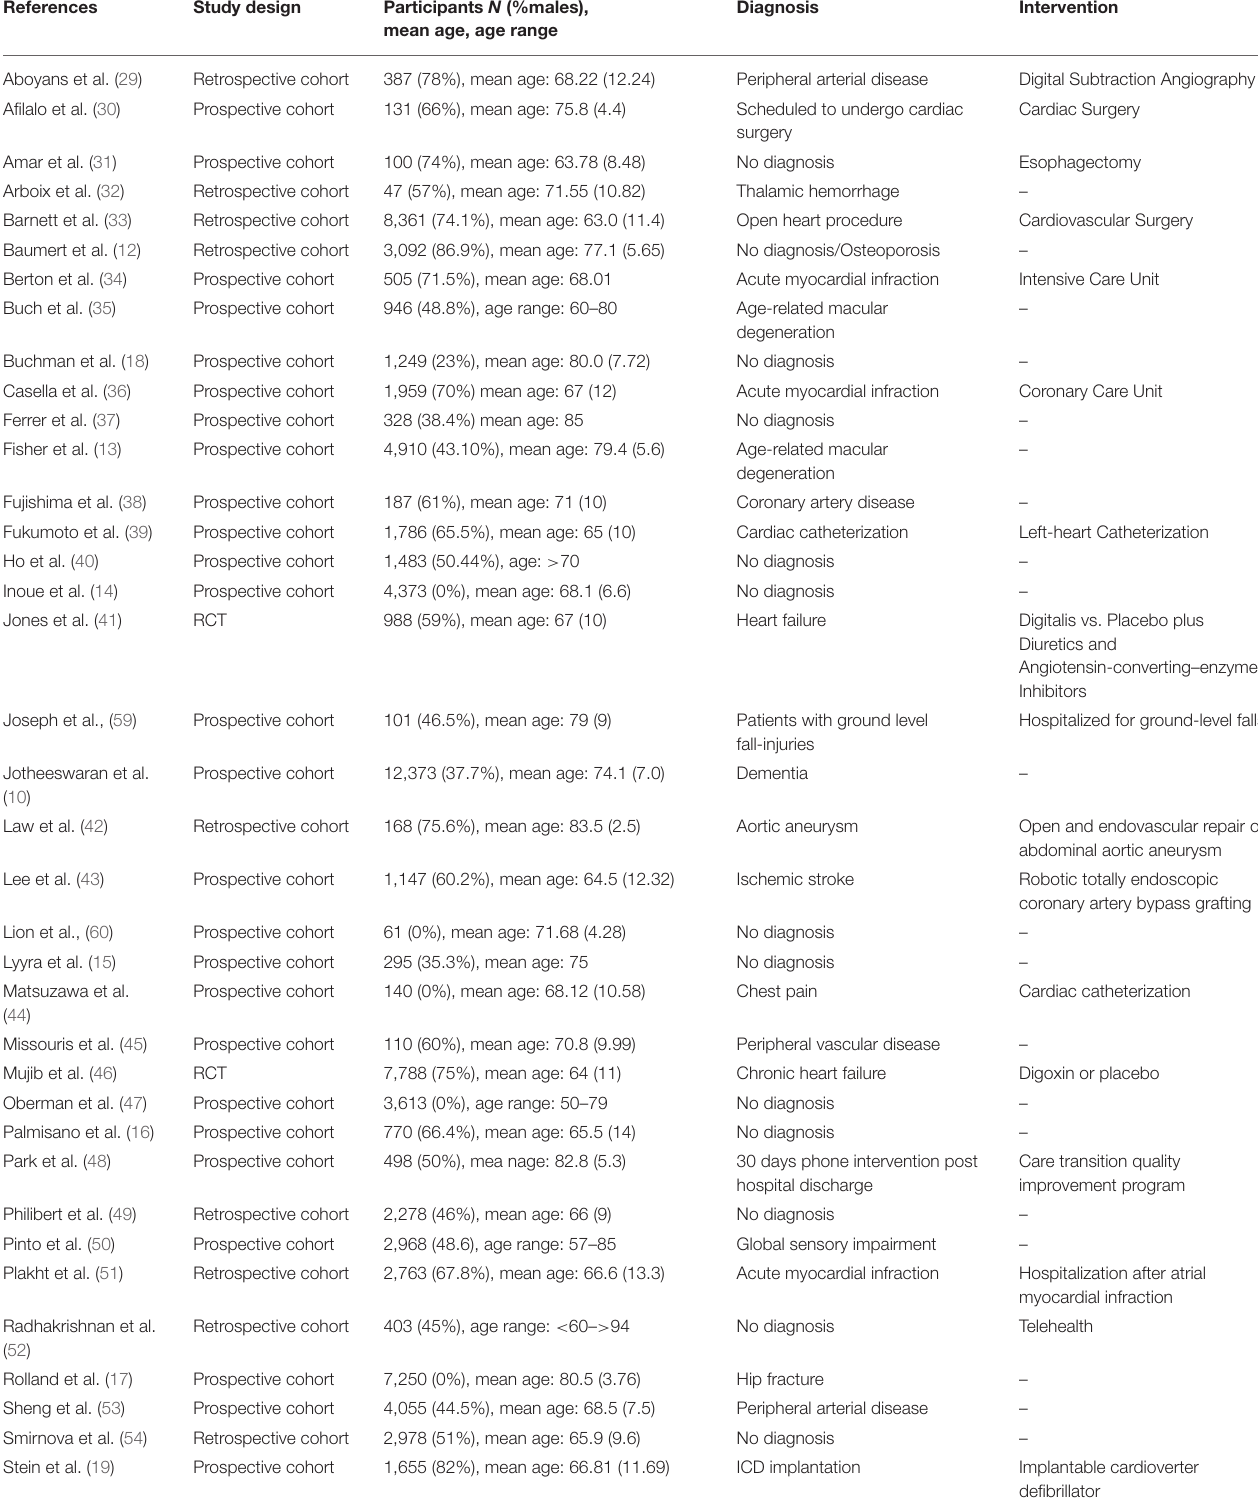
TABLE 2A | Study characteristics—demographic